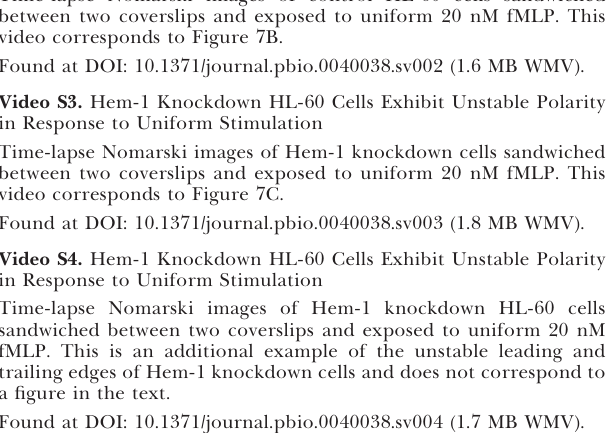
Figure S1. Only Trace Amounts of WAVE1 and WAVE3 Are Present in HL-60 Lysates Equal amounts of protein from brain lysate, control HL-60 lysate, and Hem-1 knockdown HL-60 lysate were blotted for antibodies to WAVE1, WAVE2, WAVE3, or pan-WAVE. Figure S2. Gel Filtration of Control and Hem-1 Knockdown Lysates Equal amounts of protein from control or Hem-1 knockdown HL-60 cells were separated by gel filtration on a Superose 6 column and then blotted with antibodies to son-of-sevenless 1/2, Hem-1, Rhogap4, Mypt1, or Rho guanine nucleotide dissociation inhibitor. The positions of molecular weight standards (thyroglobin, ferritin, catalase, and albumin) are noted. Note decreased high-molecular-weight pools of Rhogap4 in Hem-1 knockdown lysate. Figure S3. Actin Depolymerization Abrogates the Disparity between Control and Hem-1 Knockdown Superoxide Production Equal numbers of control and Hem-1 knockdown cells were stimulated with 100 nM fMLP, and reactive oxygen production was monitored in a luminometer. Plots represent integrated intensity for 5 min following stimulation. Indicated cells were pretreated with 1 l M latrunculin B prior to